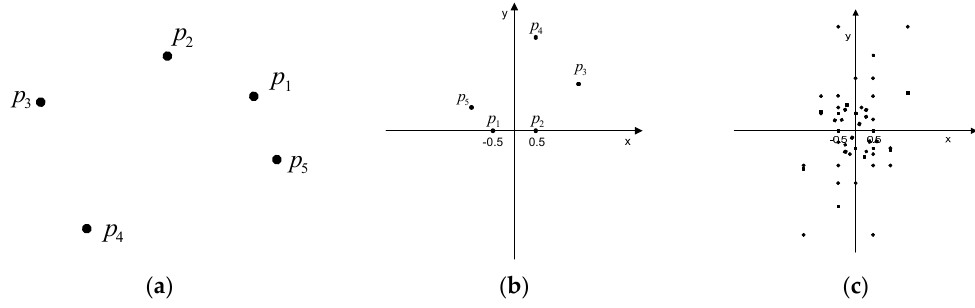
Figure 4. Geometric Hashing: ( a ) model points; ( b ) hashing table with base pair and ( c ) all hashing table entries with all base pairs.